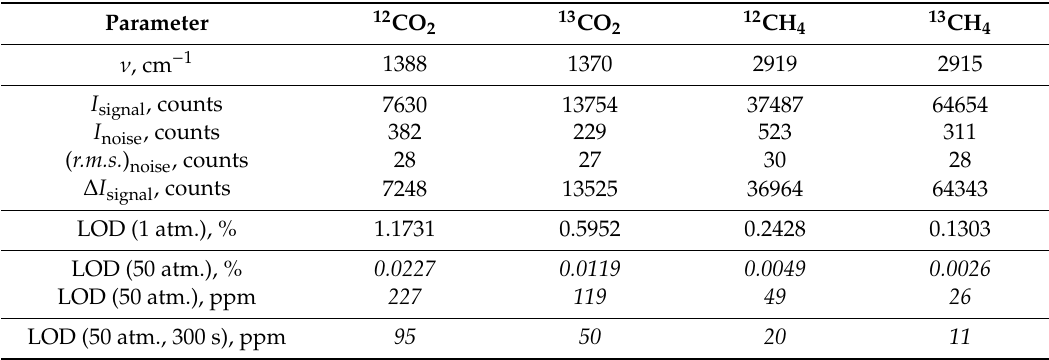
Table 2. Analysis a of the sensitivity of the Raman gas spectrometer according to the study of chemically pure isotopically enriched carbon dioxide and methane gases.